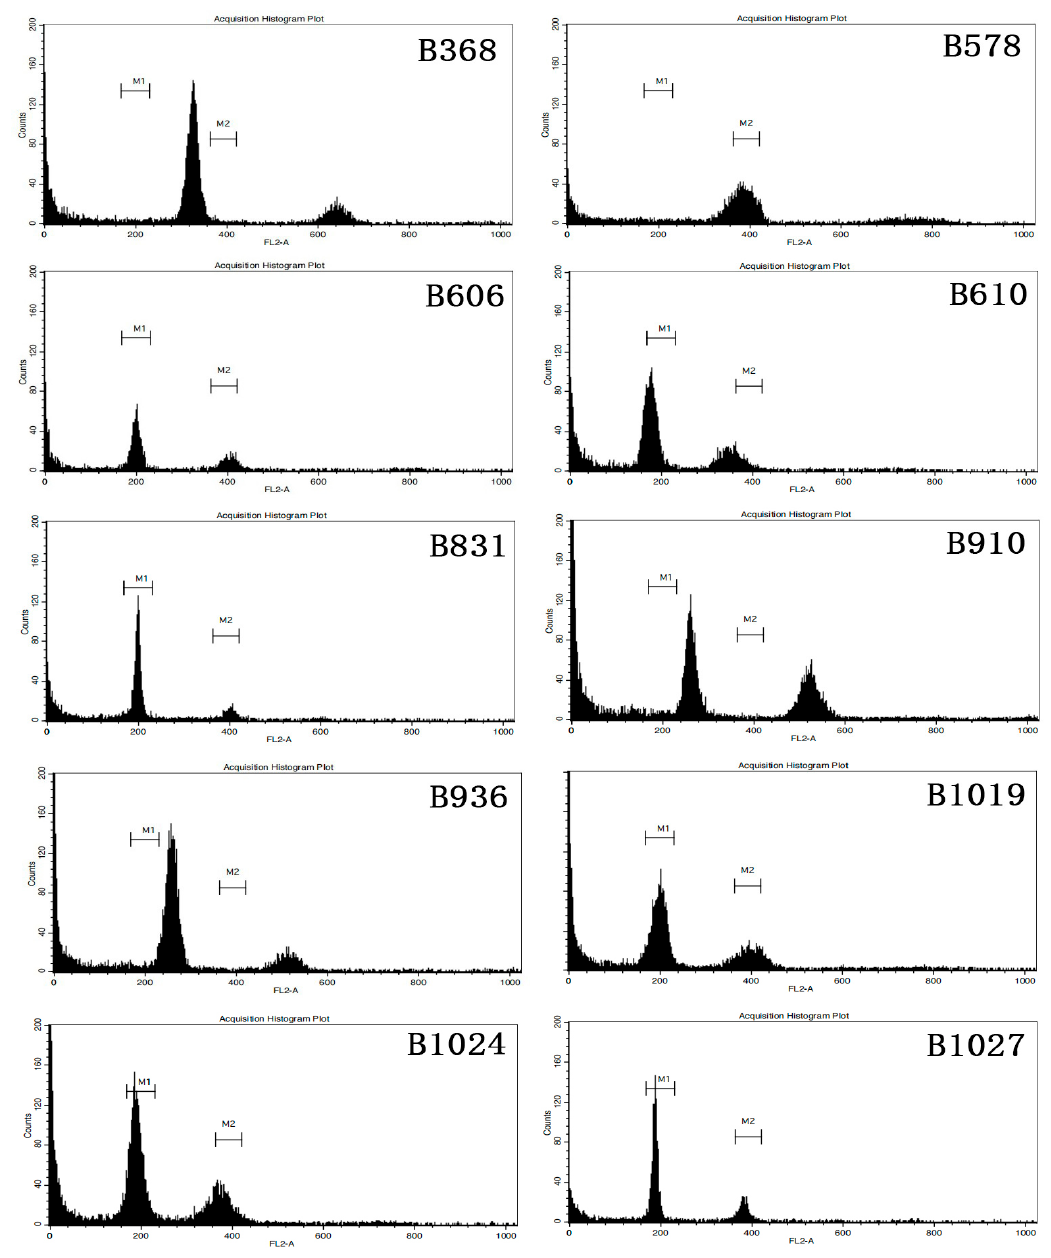
Figure 4. The detection of ploidy by flow cytometry.